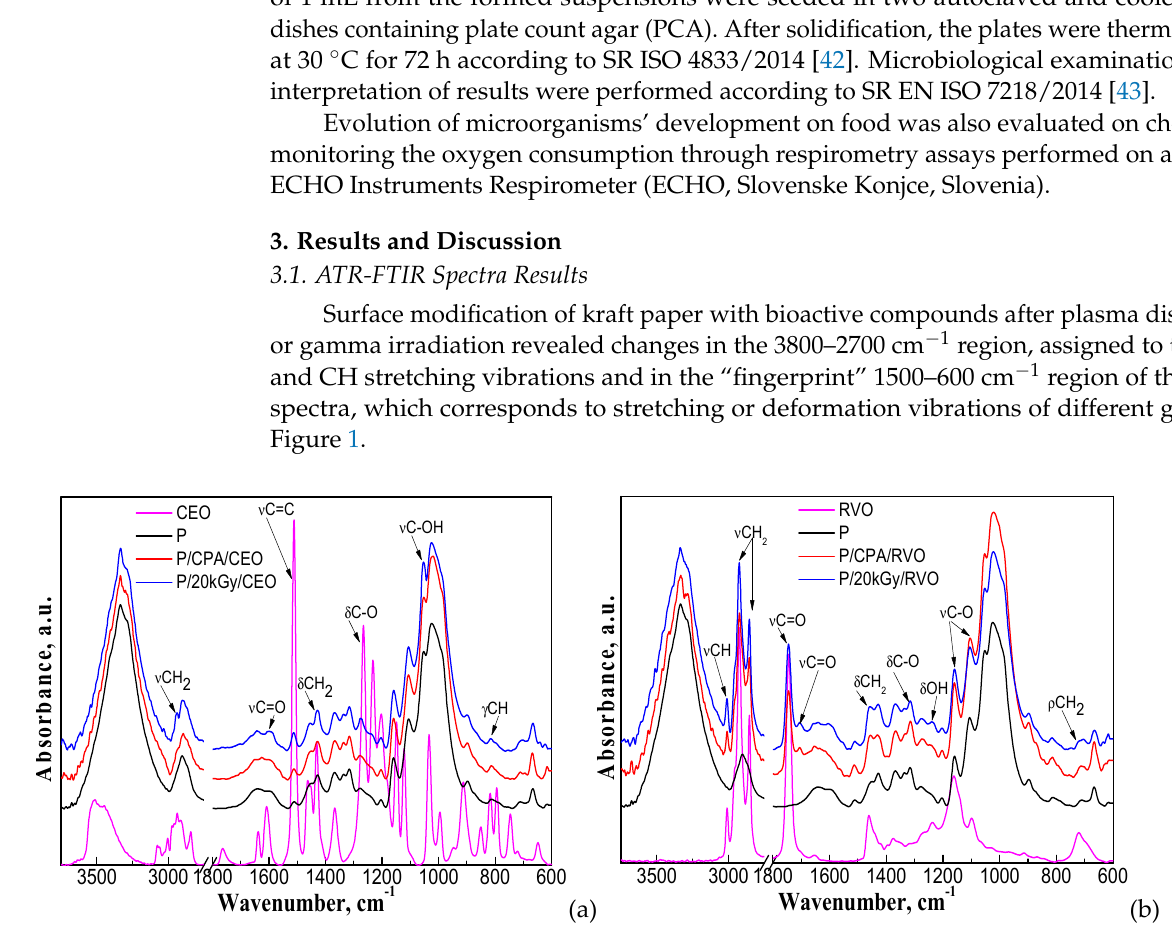
Figure 1. The infrared spectra of kraft paper activated by plasma or gamma irradiation and modified with clove essential oil (CEO) ( a ) and rosehip seeds vegetal oil (RVO) ( b ).